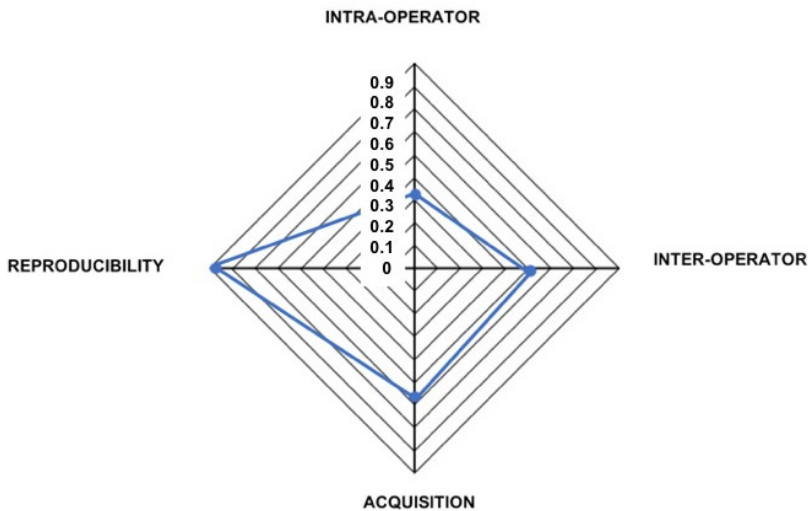
Figure 4. Total error components. This figure reports the impact of various sources of errors: the maximum intra-operator error is 0.336 mm, the maximum acquisition error is 0.496 mm, the maxi- mum inter-operator error is 0.532 mm, and the maximum reproducibility error is 0.890 mm.